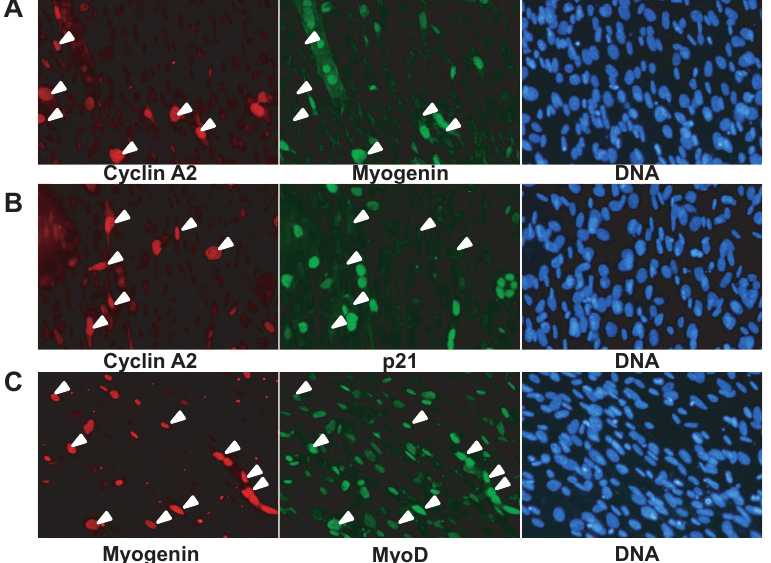
Figure 3. Myoblast double-block synchronization to the cell cycle exit point – Part 2. C2.7.4 myoblasts were fixed 24 hours after the HU- block release. Immunofluorescence was performed revealing either cyclin A2 with myogenin (A), cyclin A2 with p21 (B) and myogenin with MyoD (C). Secondary Alexa-fluor-488 and 2 455 antibodies were used for immunofluorescence detection and DNA was labeled with Hoechst. White arrows shows cyclin A2 positive cells (A and B) and myogenin positive cells (C).